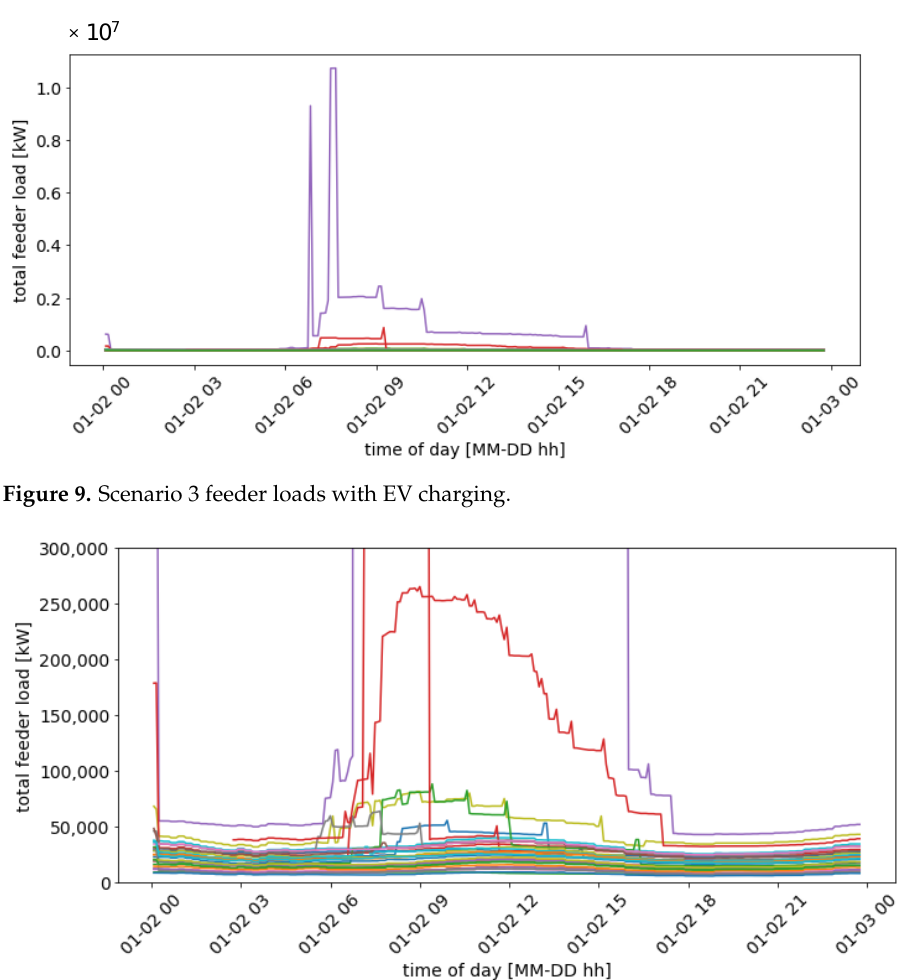
Figure 10. Scenario 3 feeder loads with EV charging zoomed-in to highlight lower load ranges.